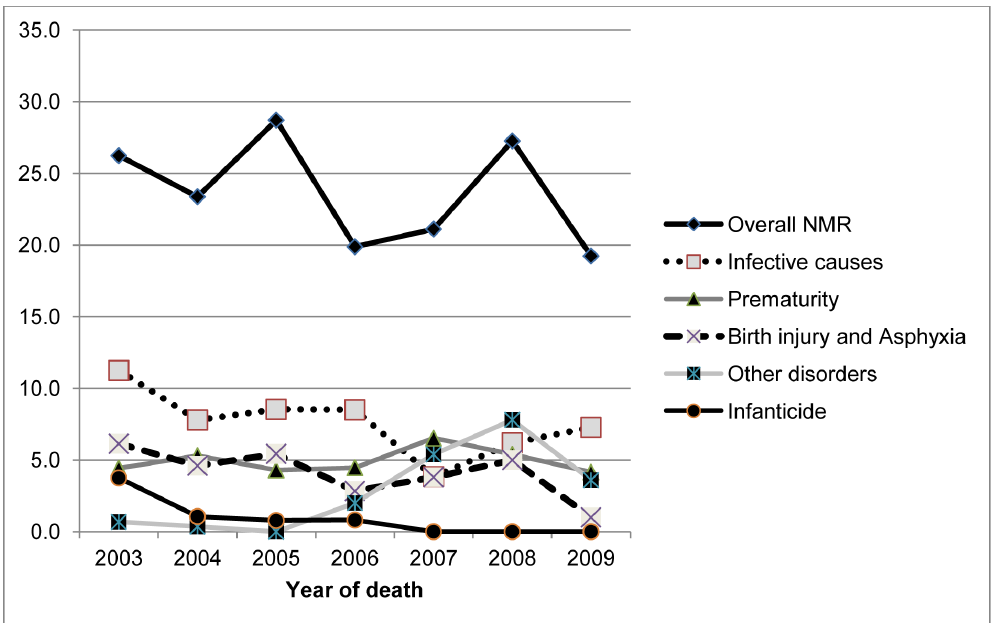
Figure 3. Trends in overall and cause-specific neonatal mortality rates in the Kassena-Nankana districts: 2003–2009 (n=424).